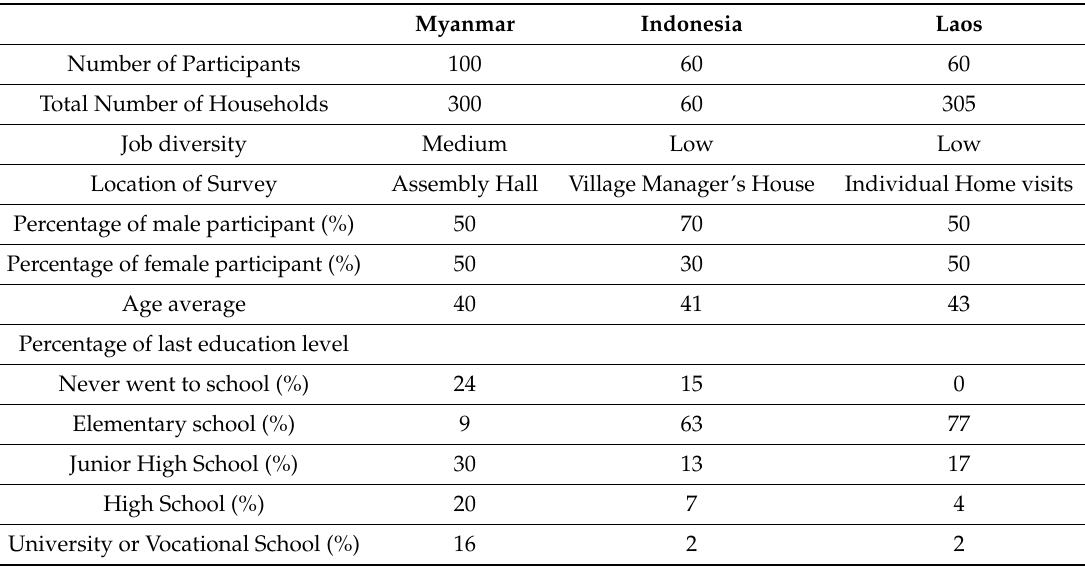
Table 1. Participants’ attributes and survey sample